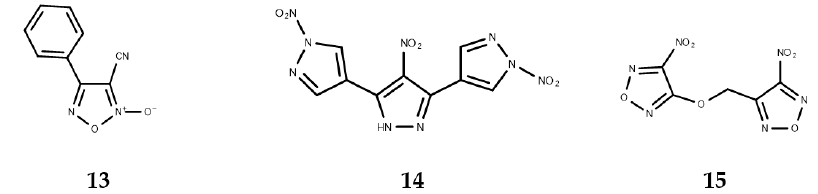
Figure 2. Oxadiazoles with antischistosomal activity.